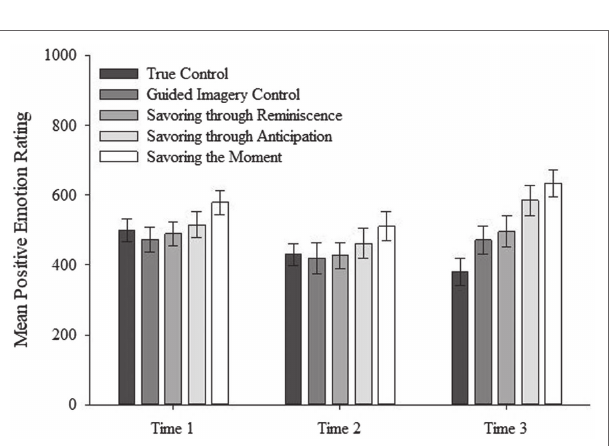
FIGURE 1 | Mean heart rate and galvanic skin response score across Time. Errors bars represent standard errors of the mean.